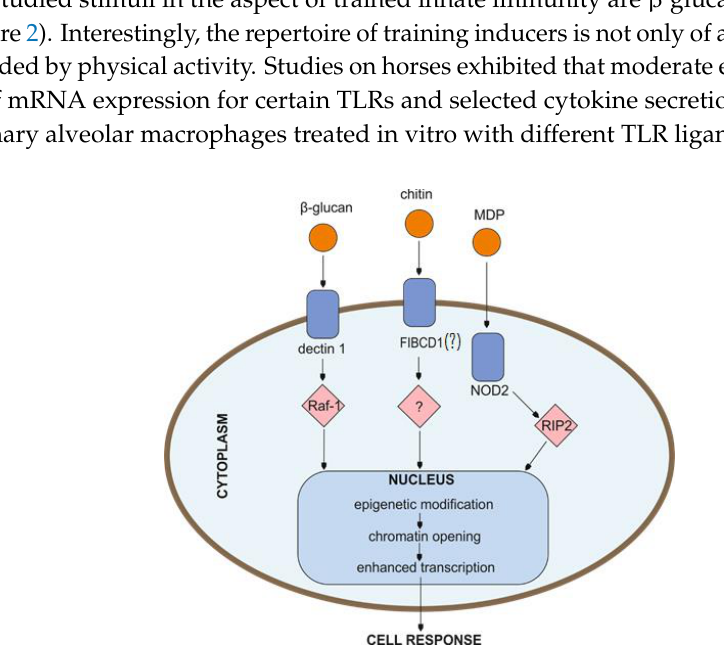
Figure 2. Potential cell signal-transduction pathways involved in the induction of trained innate immunity. Signaling pathways triggered in the response to certain stimuli lead to cell